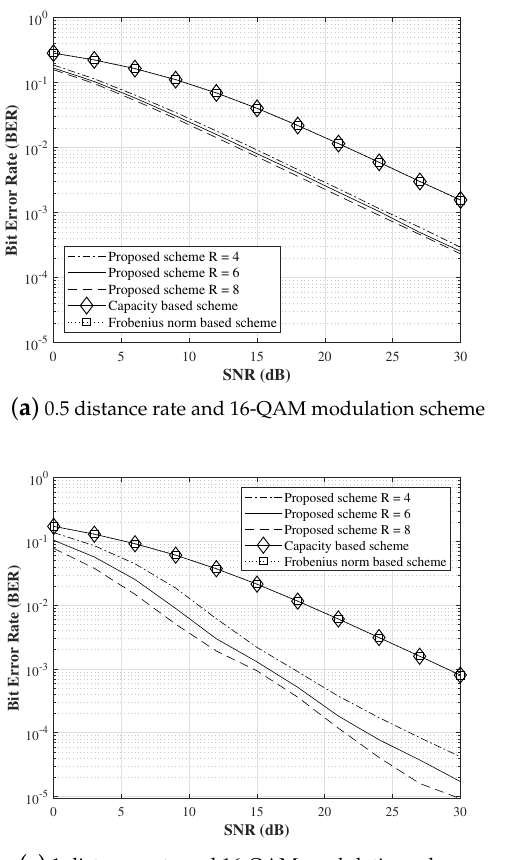
( d ) 1 distance rate and QPSK modulation scheme Figure 3. BER performance with 4